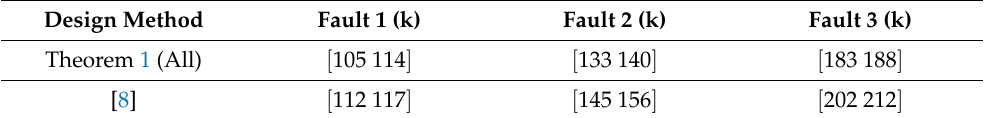
Table 1. The detection window for all FDF considering each fault after the Monte Carlo